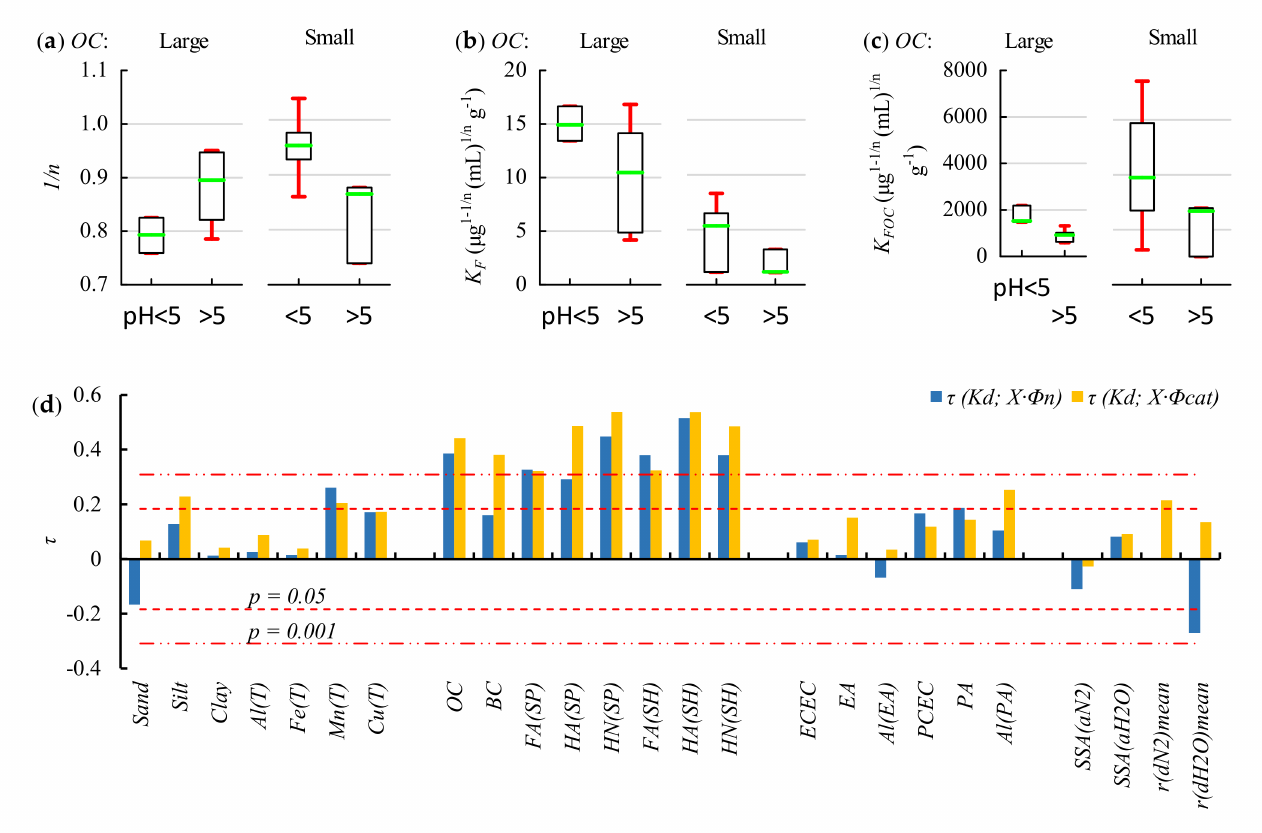
Figure 1. Result of TB adsorption experiments. ( a ) Relationships between 1 / n , ( b ) K F , ( c ) K FOC and pH in the soils with large (0.48–1.92%, n = 9) and small (0.03–0.31%, n = 9) OC contents. The box plots show the minimum, first quartile, median, third quartile, and maximum. ( d ) Kendall’s rank correlations ( τ ) between K d and 25 soil properties (for definitions see Section 3.1) multiplied by Φ n and Φ cat